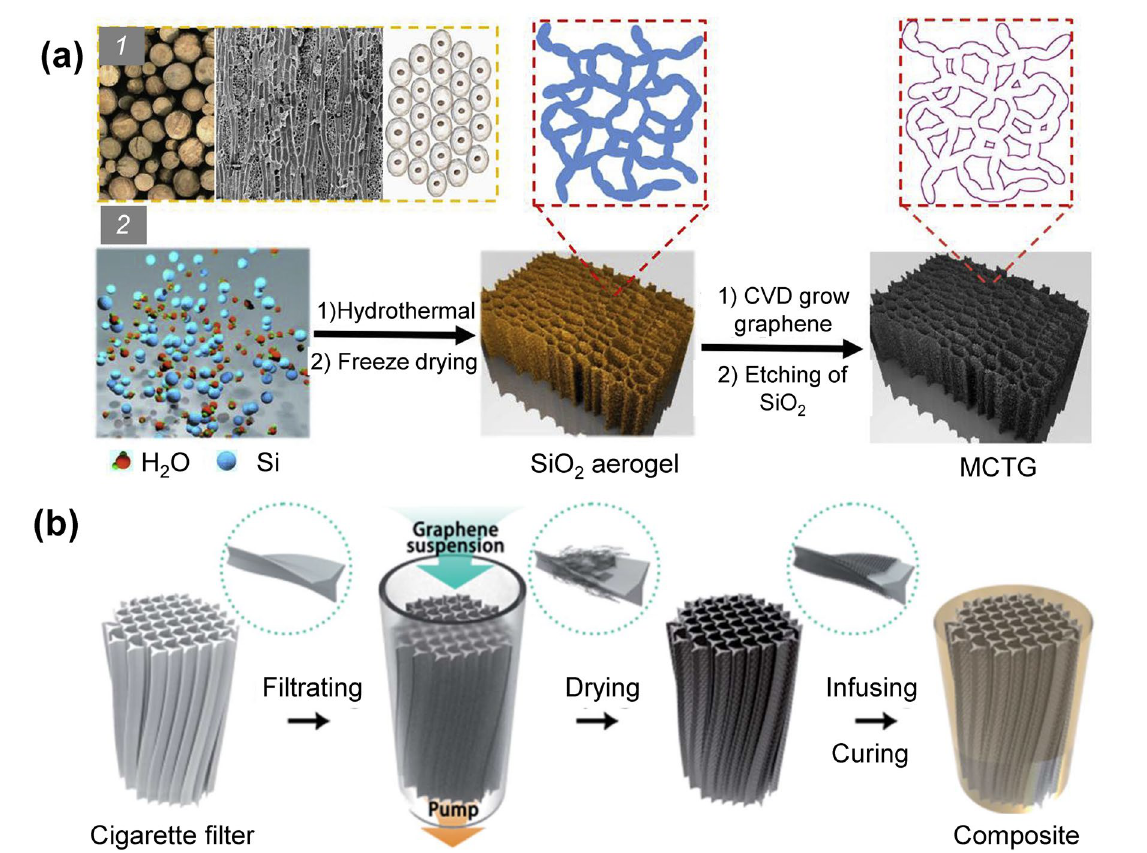
Fig. 14 Schematic illustrations of anisotropic graphene 3D networks prepared by template method and their polymer composites [212,